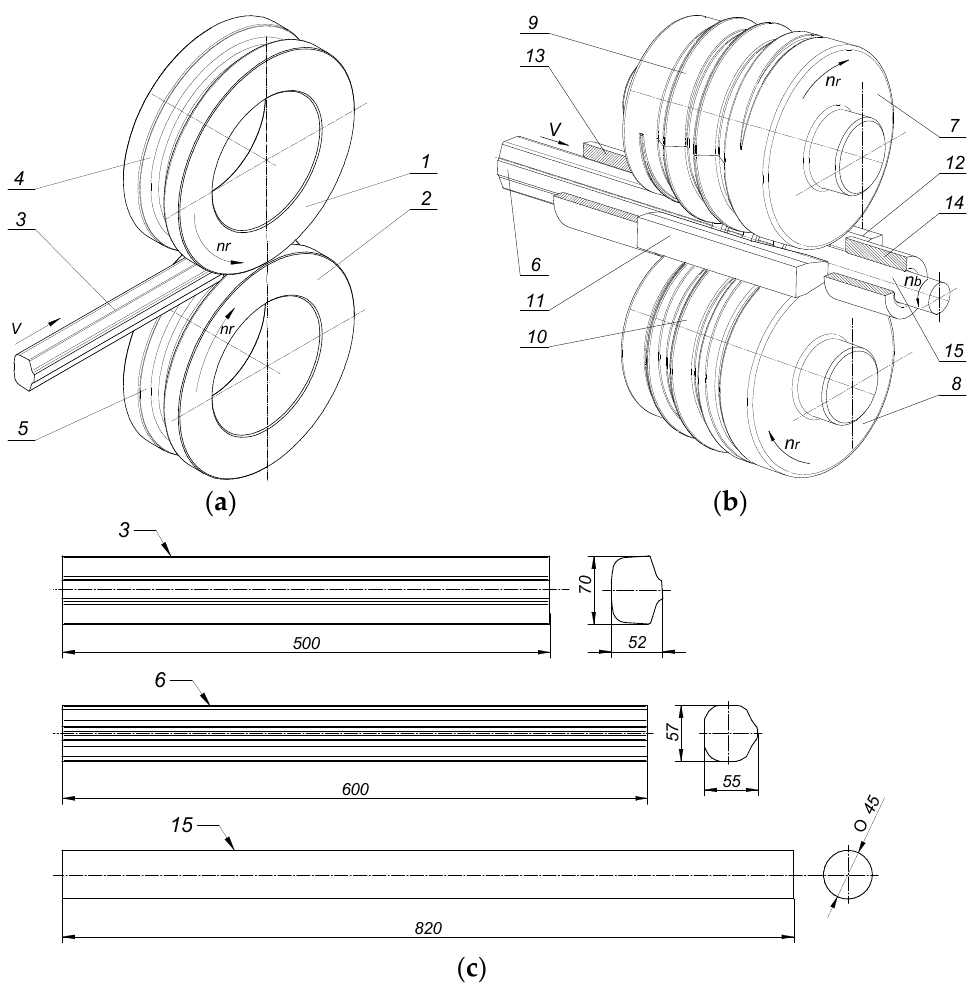
Figure 1. Schematic of rod rolling from scrap rail heads, with the dimension in mm: ( a ) rolling of a preform in a longitudinal mill; ( b ) rolling of a rod in a skew mill; ( c ) shapes of the blanks after the successive passes; 1,2—grooved rolls of the longitudinal mill; 3—rail head; 4,5—grooves forming a hexagonal pass; 6—blank with a nearly regular polygonal cross-section rolled in the longitudinal mill; 7,8—helical rolls; 9,10—helical wedge collars; 11,12—guides; 13—guiding sleeve; 14—discharge sleeve; 15—final rod product.